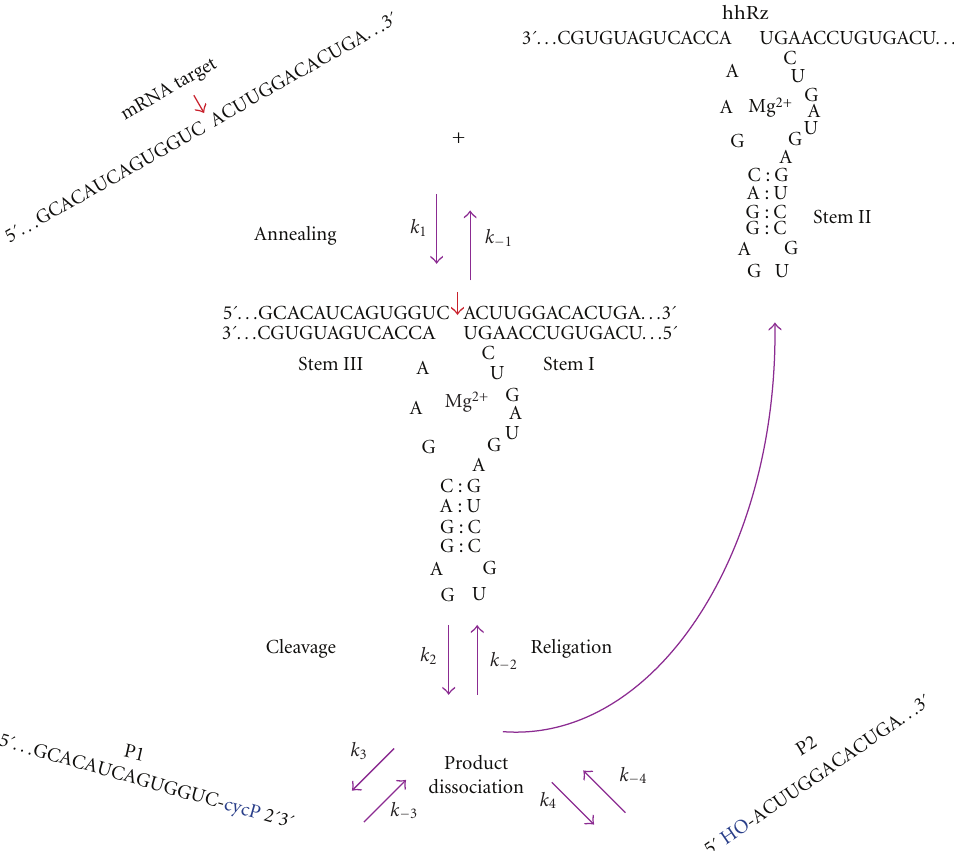
Figure 2: Ribozyme mechanism. A schematic reperesentation is shown with a simplified accessible region in a target mRNA with a cleavable hhRz NUH ↓ motif, (GUC ↓ ). The hhRz, drawn in an open enzymatically patent state, binds to the accessible target region by Watson Crick base pairing. Annealing precisely aligns the phosphodiester bond of the H residue (C here) with the enzymatic core of the catalytic RNA. The annealing reaction has an equilibrium specified by the ratio of rates k 1 and k − 1 . Chemical cleavage ( k 2 ) occurs to yield two products which remain bound to the AS flanks of the hhRz. Each product leaves with its own characteristic equilibrium determined by the strength of binding to the hhRz AS flanks. Product dissociation permits the enzyme to collide with another substrate and initiate subsequent rounds of catalysis as a Michaelis-Menten enzyme to achieve catalytic target turnover characterized by k cat /K m .